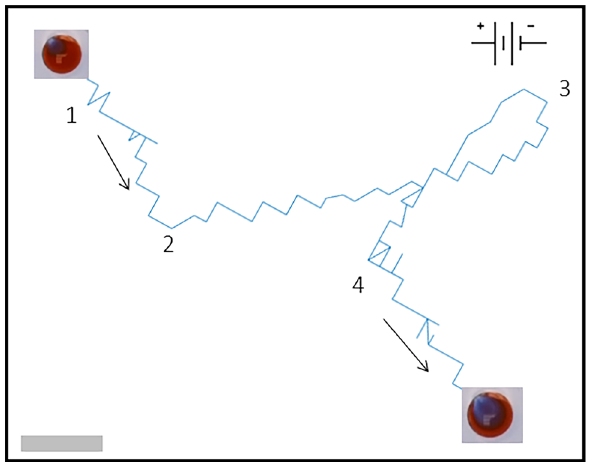
Figure 1. Trajectory of a BZ droplet moving under a DC electric field. The electric field was applied with direction horizontally from left to right, see the setup sketched in the top right corner. The droplet initially drifts along a path diagonally across the figure, as indicated by the black arrow with Label 1, but undergoes a chemically-driven translational motion from Point 2 to Point 3 in accordance with the direction of the electric field and also chemical wave propagation across the droplet body. After that, its trajectory shows a partial reset with the droplet moving back from Point 3 towards Point 2, but does not reach there. Due to the cessation of the chemical wave propagation, the droplet resumes its original drifting in the direction marked by the arrow with Label 4. The video clip recording this trajectory can be found in the SI. The scale bar at the lower-left corner represents 0.5 mm of the droplet